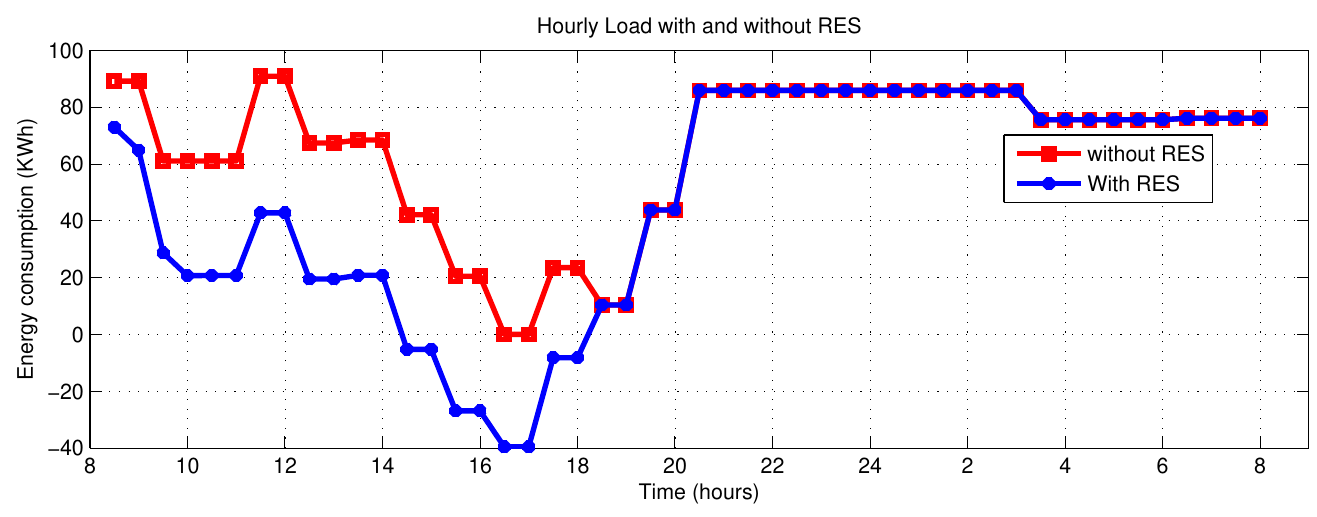
Figure 11. Un-scheduled load with and without RES.